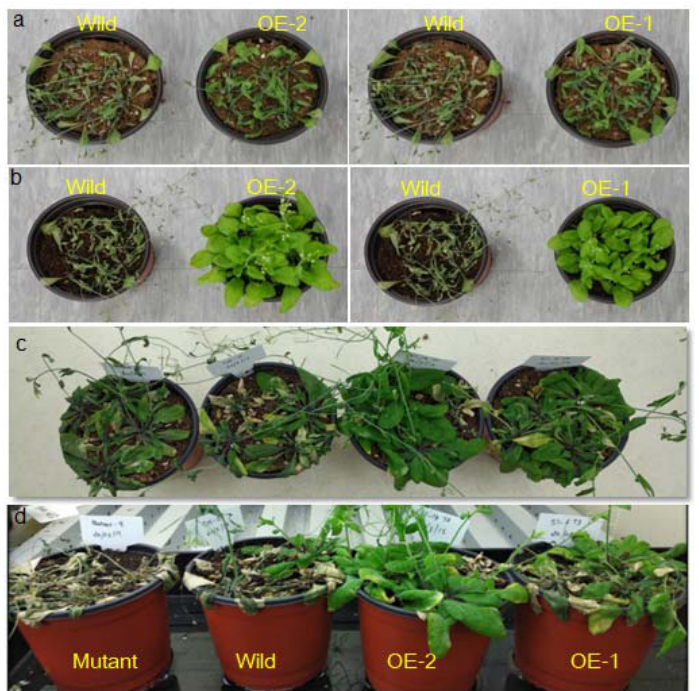
Figure 4. Drought phenotyping of BrSR45a overexpressors (OE-1, OE-2), SR45a mutants and wild type lines subjected to progressive drought stress. ( a , c ) depict plants subjected to 11 and 17 d of progressive drought stress, while ( b , d ) represent plants after a stress recovery period of 1 d.